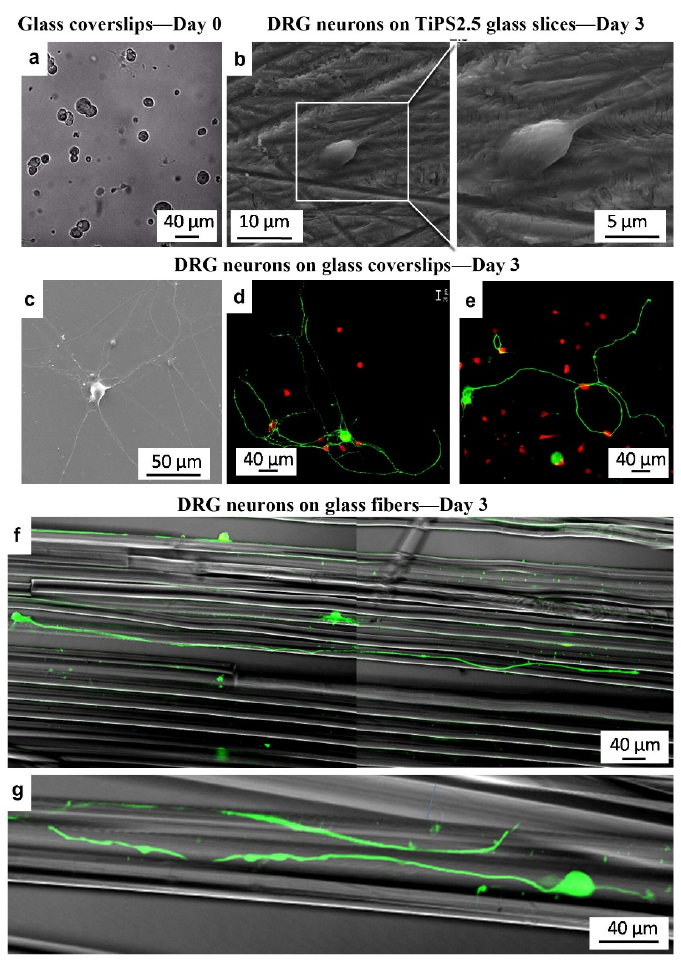
Figure 5. ( a ) Inverted microscope images presenting dorsal root ganglion (DRG) neurons on a glass coverslip at day 0, showing a rounded morphology; ( b ) SEM micrographs of DRG neurons at 3 days post-incubation on glass slices containing 2.5% Ti (mol.%); ( c ) SEM and ( d ) confocal microscope micrographs showing DRG neurons at 3 days post-incubation on glass coverslips. ( e ) Confocal microscope images exhibiting DRG neurons at 3 days post-incubation on glass coverslips, showing long neurites; ( f ) and ( g ) DRG neurons on 25 µm glass fibers containing 2.5% Ti (mol.%), presenting long neurites extended along the fiber axis direction. TiPS2.5: phosphate glasses with composition (mol.%) 50P 2 O 5 –30CaO–9Na 2 O–3SiO 2 –3MgO–(5 – x)K 2 O–xTiO 2 , with x equal to 2.5. Reproduced